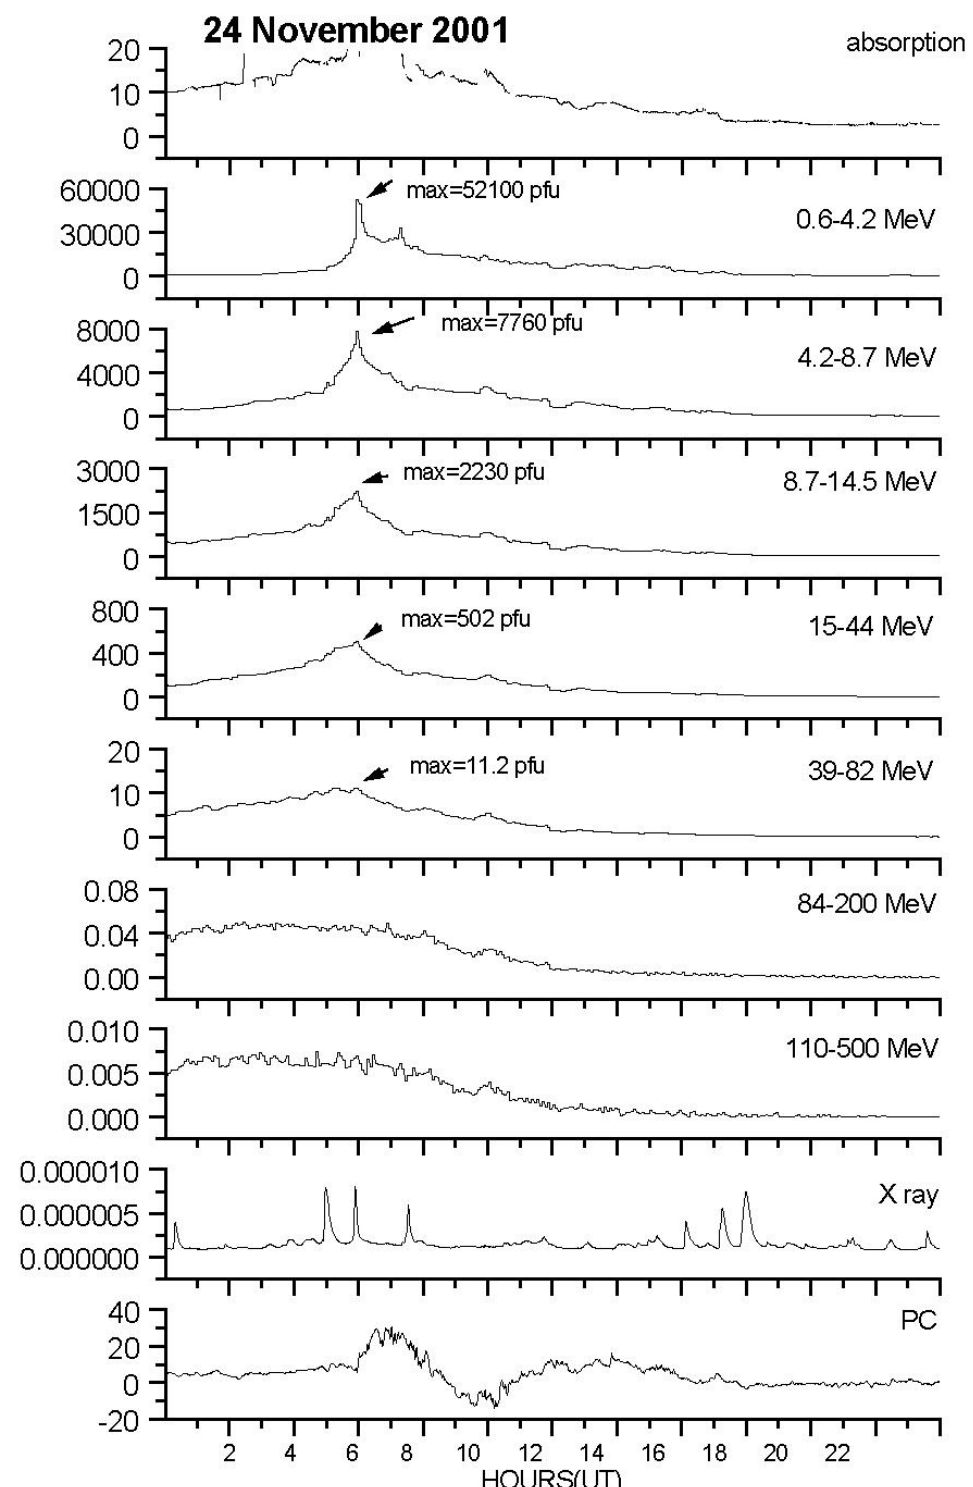
Fig. 8. As Fig. 1, but for 24